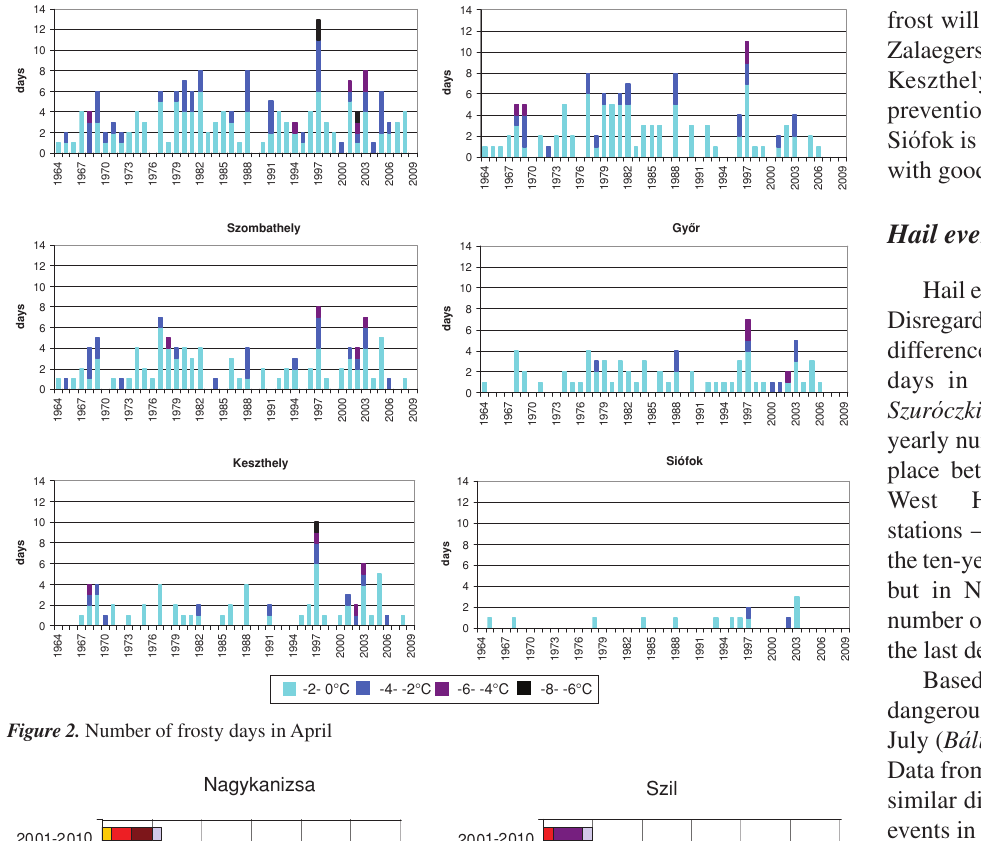
Figure 2. Number of frosty days in April